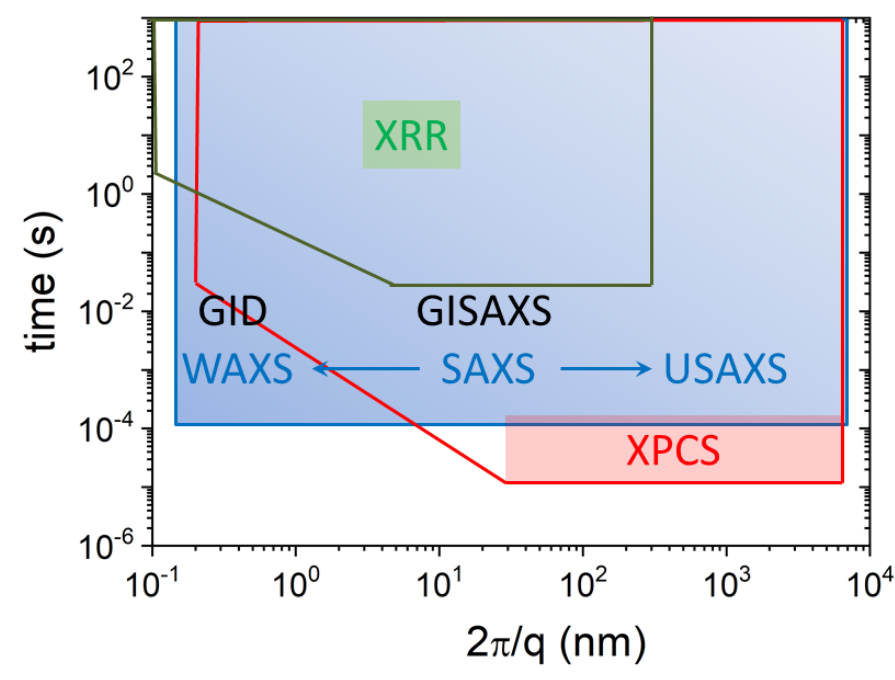
Figure 24. Nominal size and time scales accessible by different synchrotron X-ray scattering methods using 2D detectors. The exact range depends on the scattering features and contrast of the sample. For XPCS the smaller scales are limited by the longitudinal coherence, flux and detector